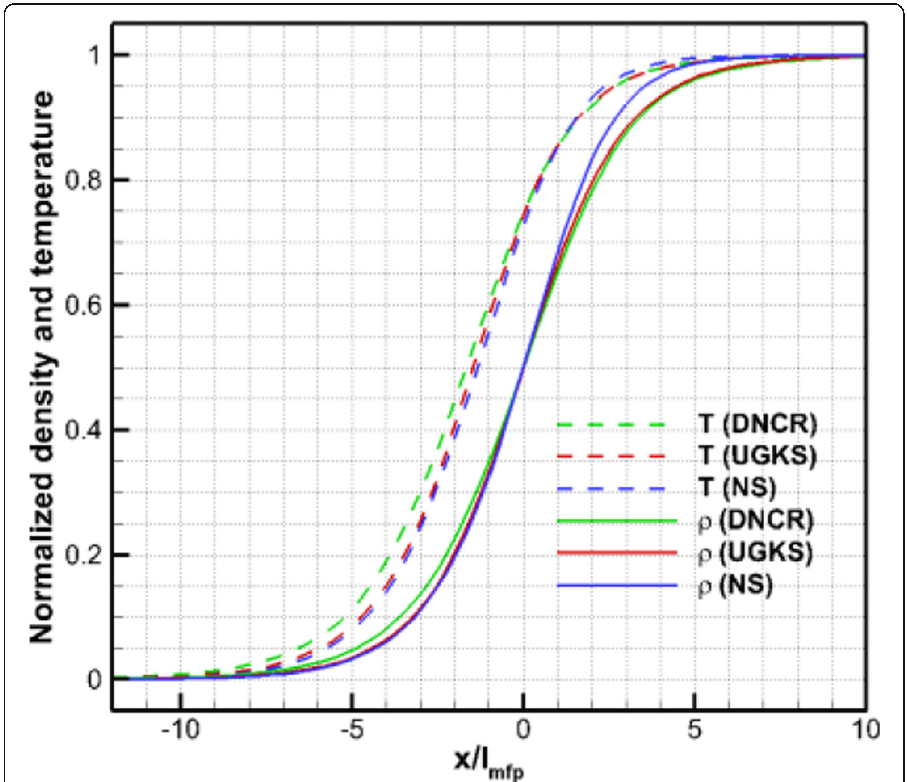
Fig. 2 Comparisons of flow variables in shock structure in a monatomic gas using the NS, UGKS and DNCR at Mach